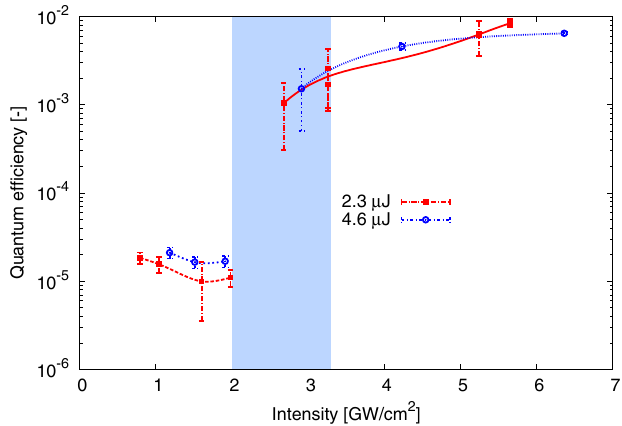
FIG. 6. Quantum efficiency versus laser intensity for an etched, nonreacted wire at two different laser energies. For each energy, the laser intensity is modified by changing the laser spot size and keeping the laser power constant. The QE is calculated using Eq. (2). The blue region marks an unstable operation of the gun between the low and the high charge regime as shown by the much larger error bars. The lines are a guide to the eye.